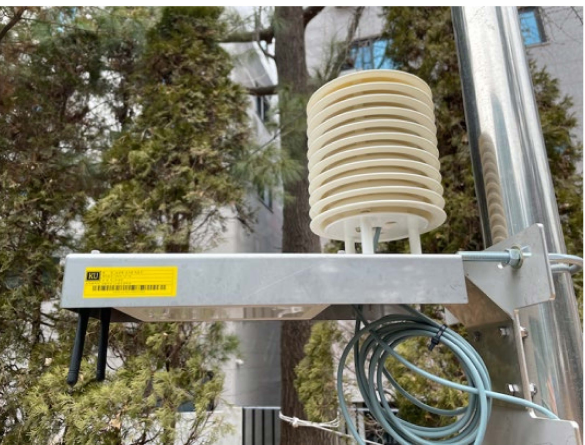
Figure 3. Air with a flow rate of 0.1 L per minute enters the sensor through the inlet and generates light scattering, which identifies the size and number concentration of PM particles and calculates the PM